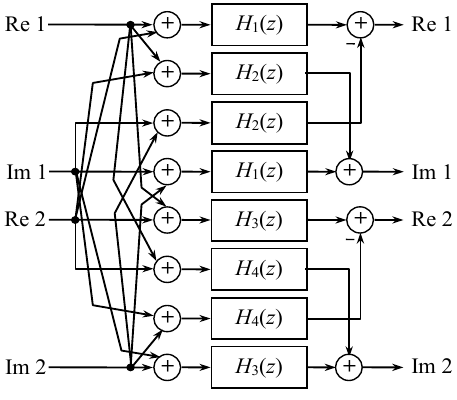
Fig. 2. Block diagram of a bicomplex filter.